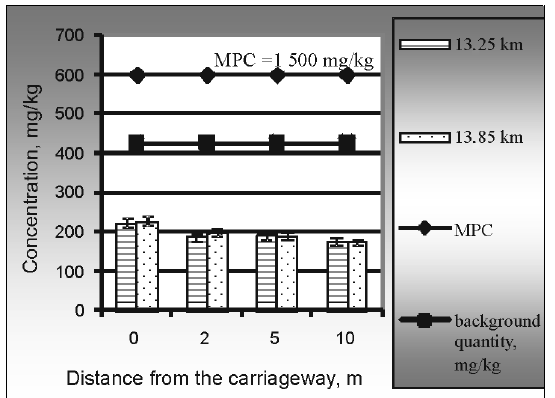
Fig. 7. Manganese concentration in the roadside soil of the gravel road Jusevičiai – Būdvietis – Derviniai